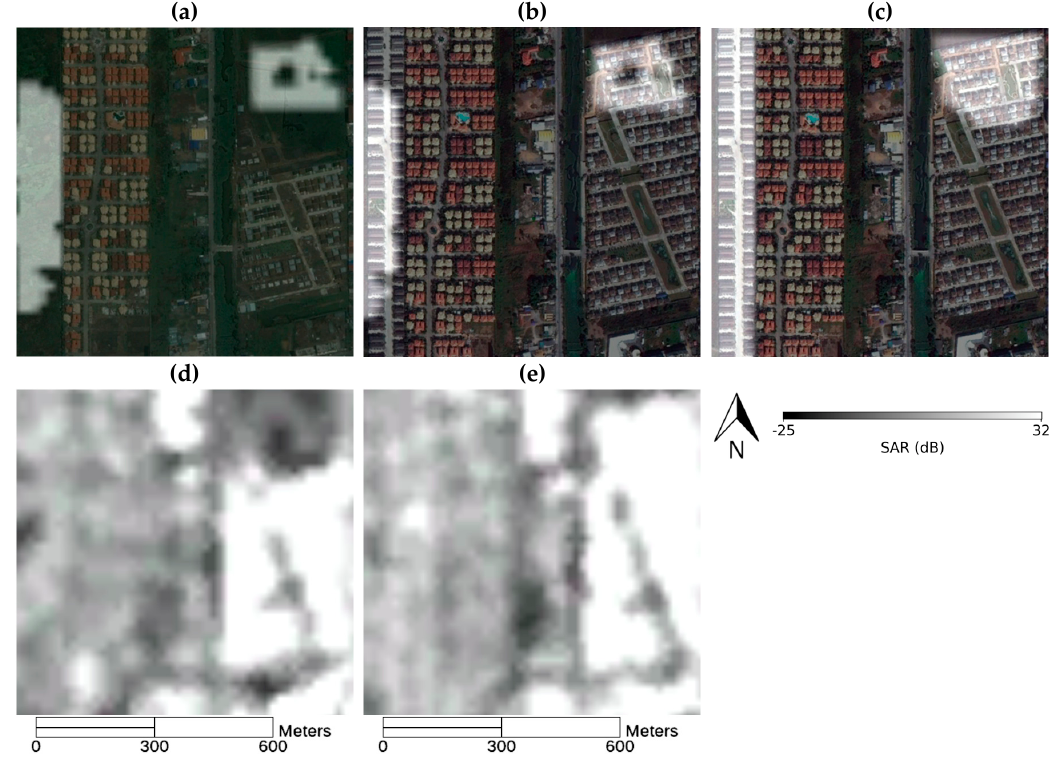
Figure 18. Example of detection results of CORN at Bangkok testing site for SAR pairs 12 January 2009/21 November 2009. (a) CORN result overlays on Time 1 optical image, (b) CORN result overlays on Time 2 optical image, (c) ground truth overlays on Time 2 optical image, (d) Time 1 SAR image, (e) Time 2 SAR image.